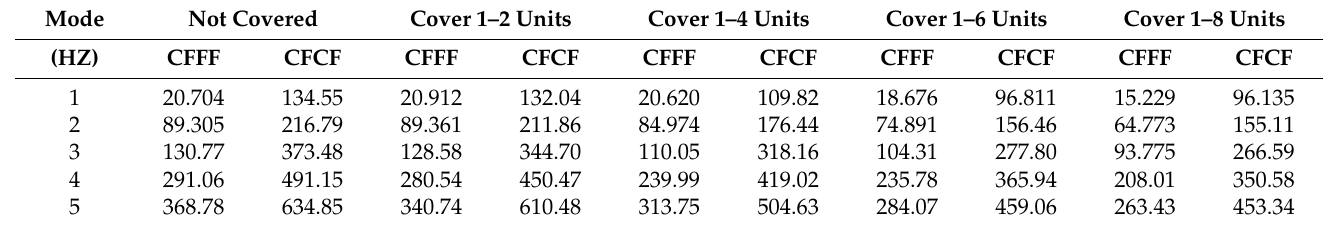
Figure 5. Sandwich plate unit covering method diagram. Table 2. Natural Frequencies of Sandwich plate Element Covered in Order under Two Boundary Conditions.